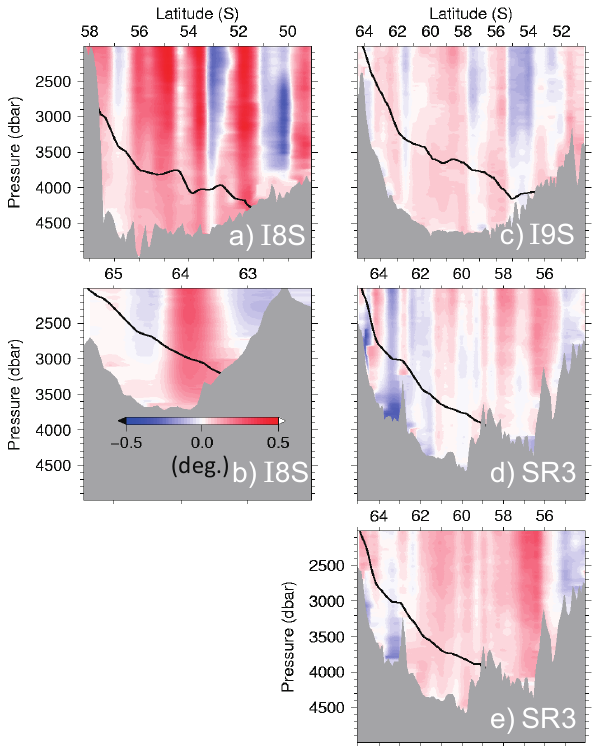
Fig. 4. Difference in isobaric potential temperature between the WHP and repeat occupations. Red areas indicate warming and blue areas indicate cooling. (a) I8S (the Australian-Antarctic Basin), (b) I8S (the PET), (c) I9S, (d) SR3 (obtained from subtracting the WHP from combined repeat occupations in the year 2001, 2002, and 2003), (e) SR3 (obtained from subtracting the WHP from repeat occupations in the year 2008). Mean γ n = 28 . 30kgm − 3 isopycnals are shown by solid lines.